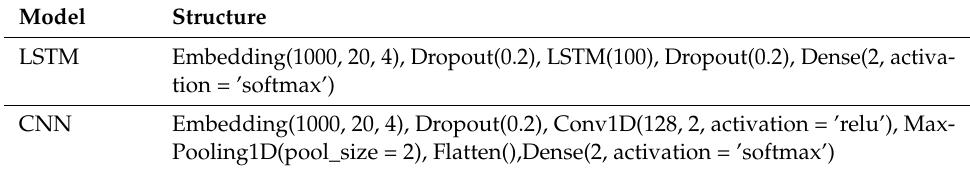
Table 4. Architecture of deep-learning